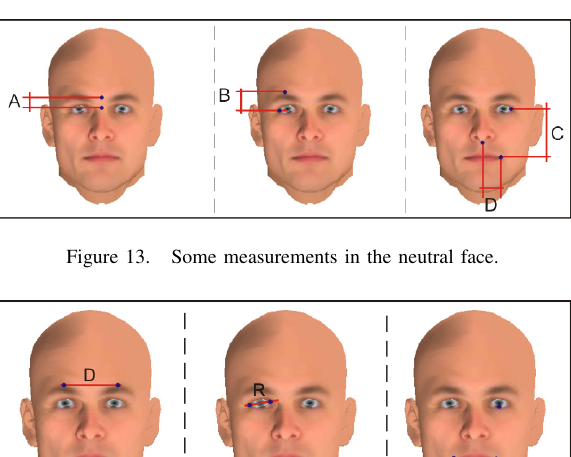
Figure 12. Base model and the landmarks used in this case study.